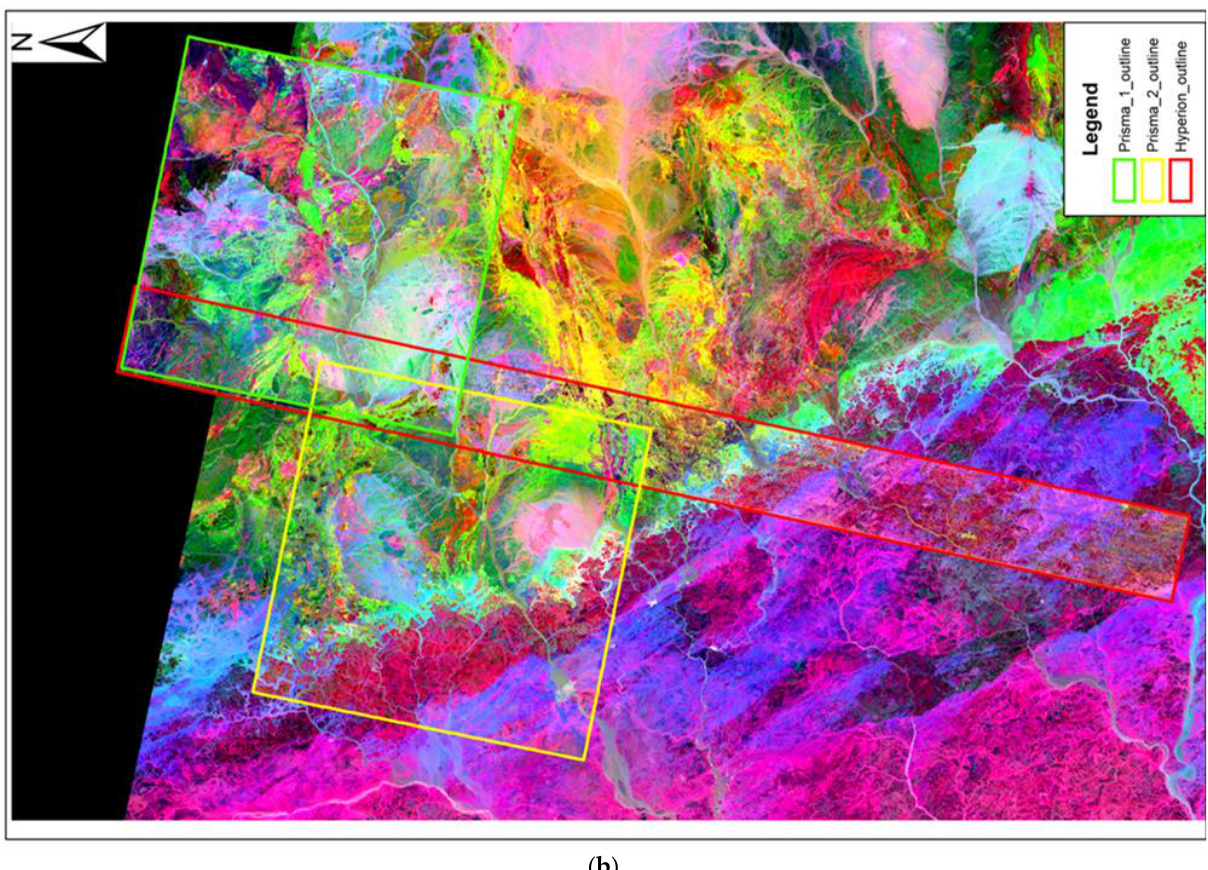
Figure 15. Abrams band ratio for ( a ) the original Hyperion scene and Prisma on the Landsat 8 back- ground and ( b ) the original Hyperion scene and Prisma superimposed on the predicted Hyperion background